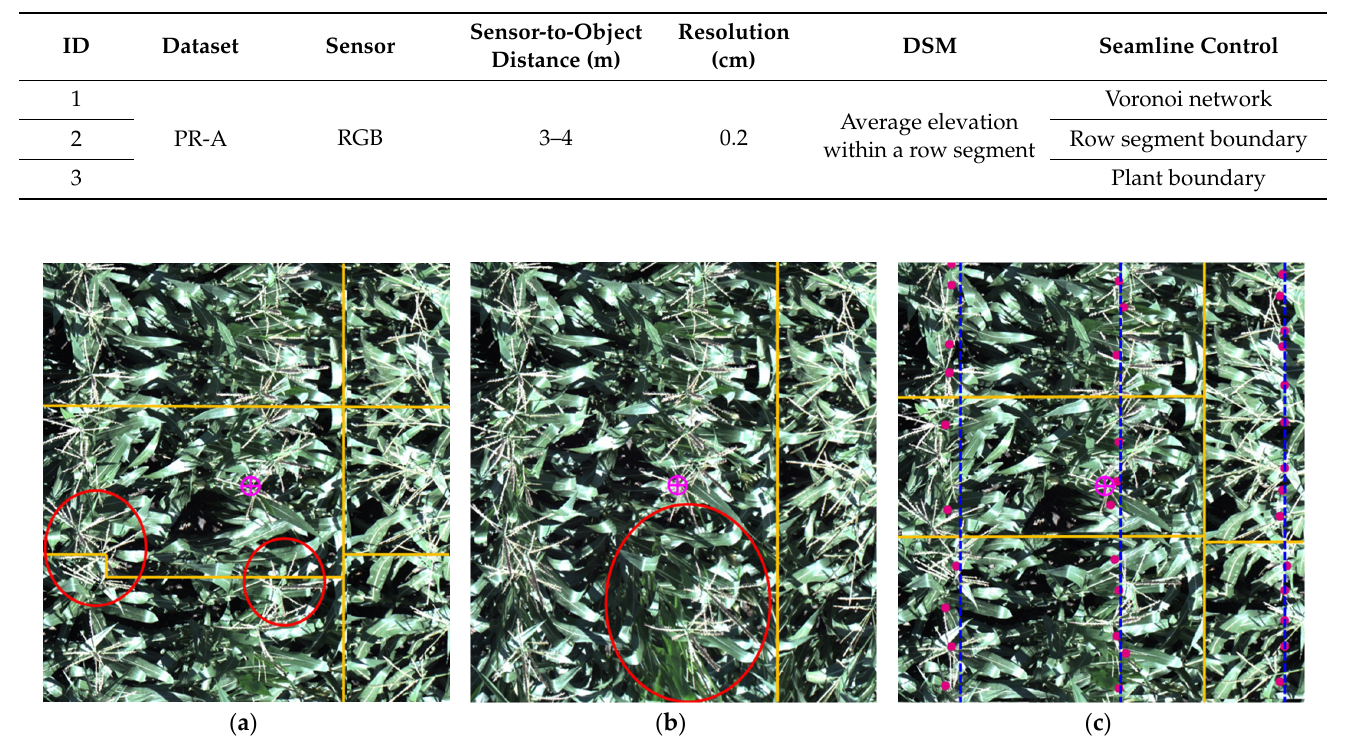
Table 5. Experimental setup of the system, sensor, sensor-to-object distance, resolution, DSM, and seamline control strategy for orthophoto 1 to 3.